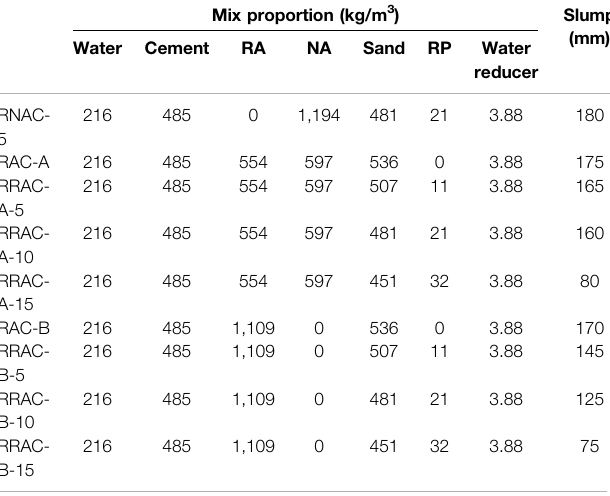
TABLE 1 | Mix proportion and slump of RNAC and